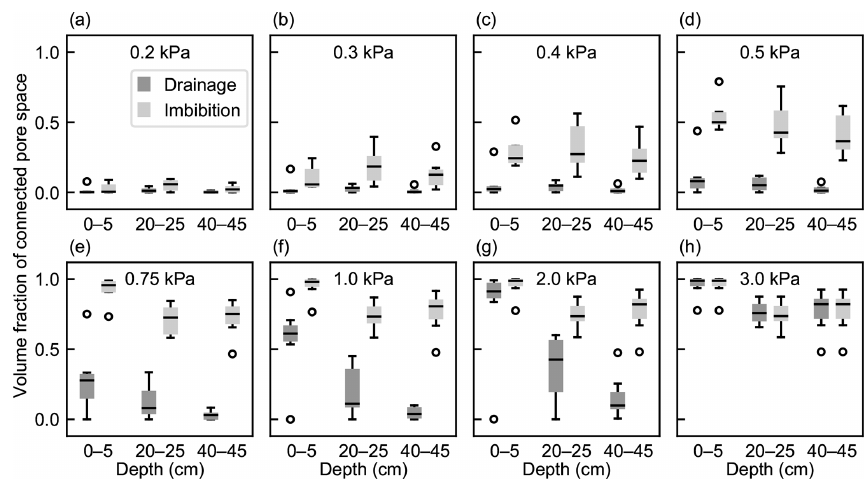
Figure 9. Volume fractions of air-filled pore networks of total peat macropore space at external pressures of (a) 0.2kPa, (b) 0.3kPa, (c) 0.4kPa, (d) 0.5kPa, (e) 0.75kPa, (f) 1.0kPa, (g) 2.0kPa, and (h) 3.0kPa in drainage and imbibition simulations ( n = 7 in 0–5 and 40–45cm, n = 5 in drainage and n = 6 in imbibition in 20–25cm). Boxes indicate the interquartile range; whiskers extend at most to 1.5 times the interquartile range from the first and from the third quartile, and the black line shows the